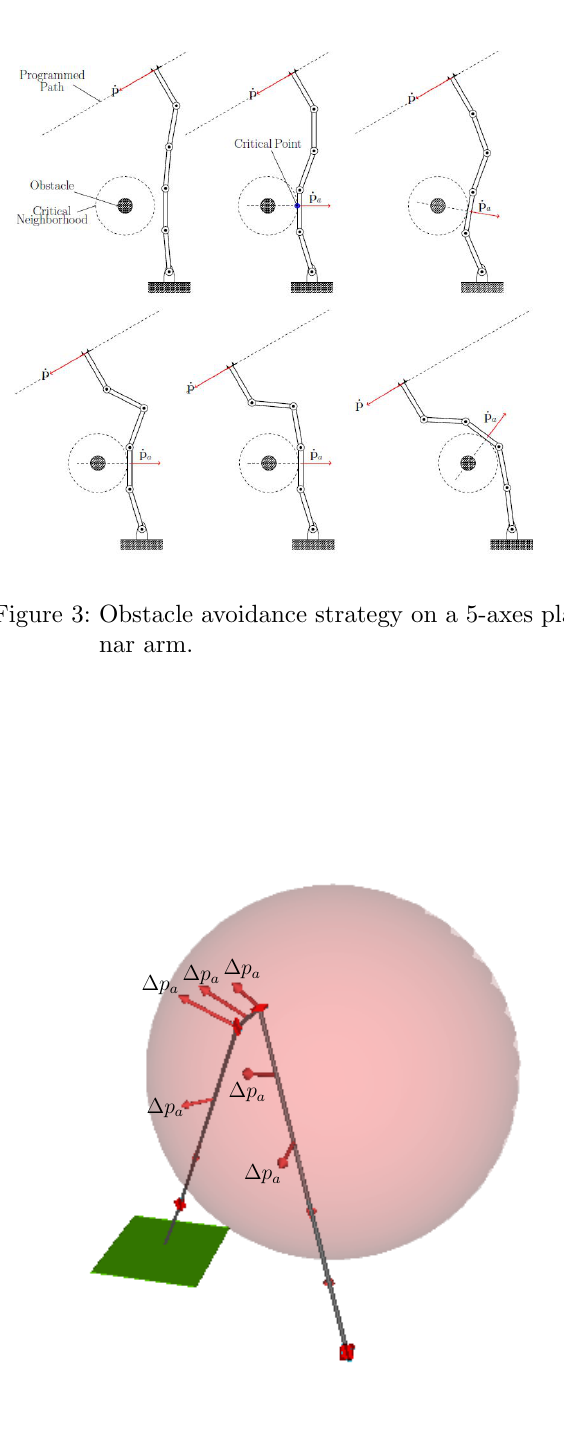
Figure 4: Wireframe of an industrial robot partially in a risky